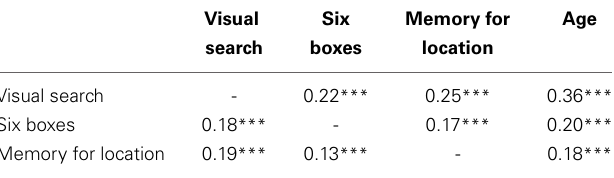
Table 2 | Correlations between continuous executive function